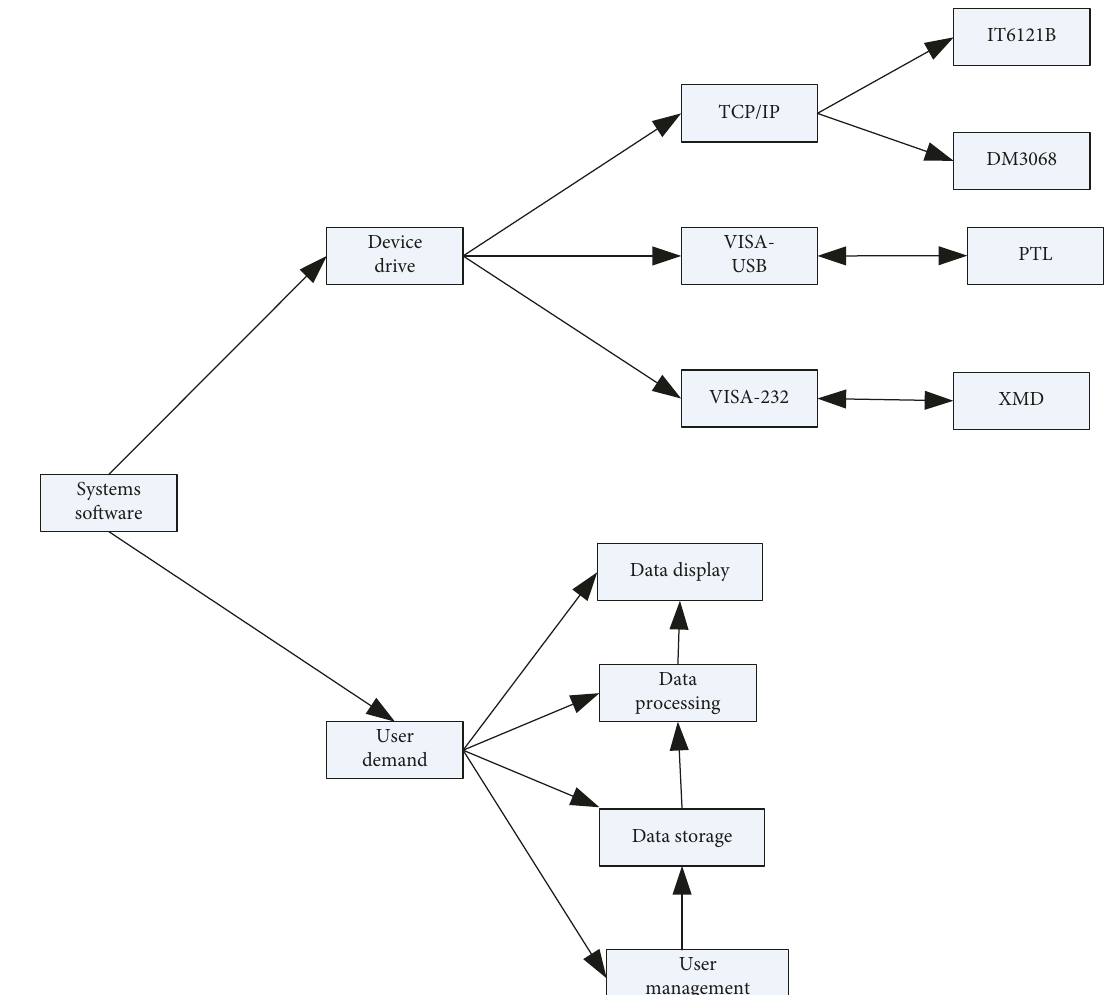
Figure 2: LED software test